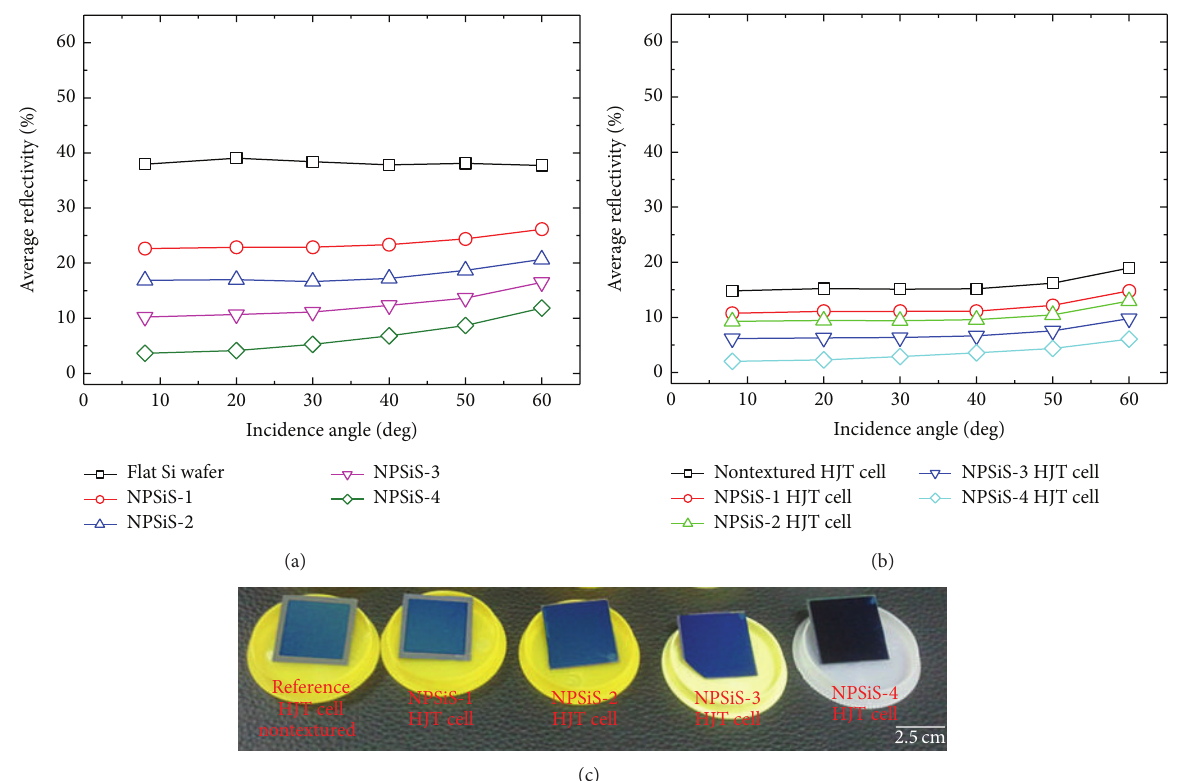
Figure 6: Average reflectance results achieved with light at angles of incidence from 8 degrees to 60 degrees at wavelengths between 350 nm and 950 nm; (a) flat Si wafer and NPSiS wafer, (b) nontextured HJT cell and four NPSiS HJT cells, and (c) photograph of reference HJT cell and NPSiS HJT